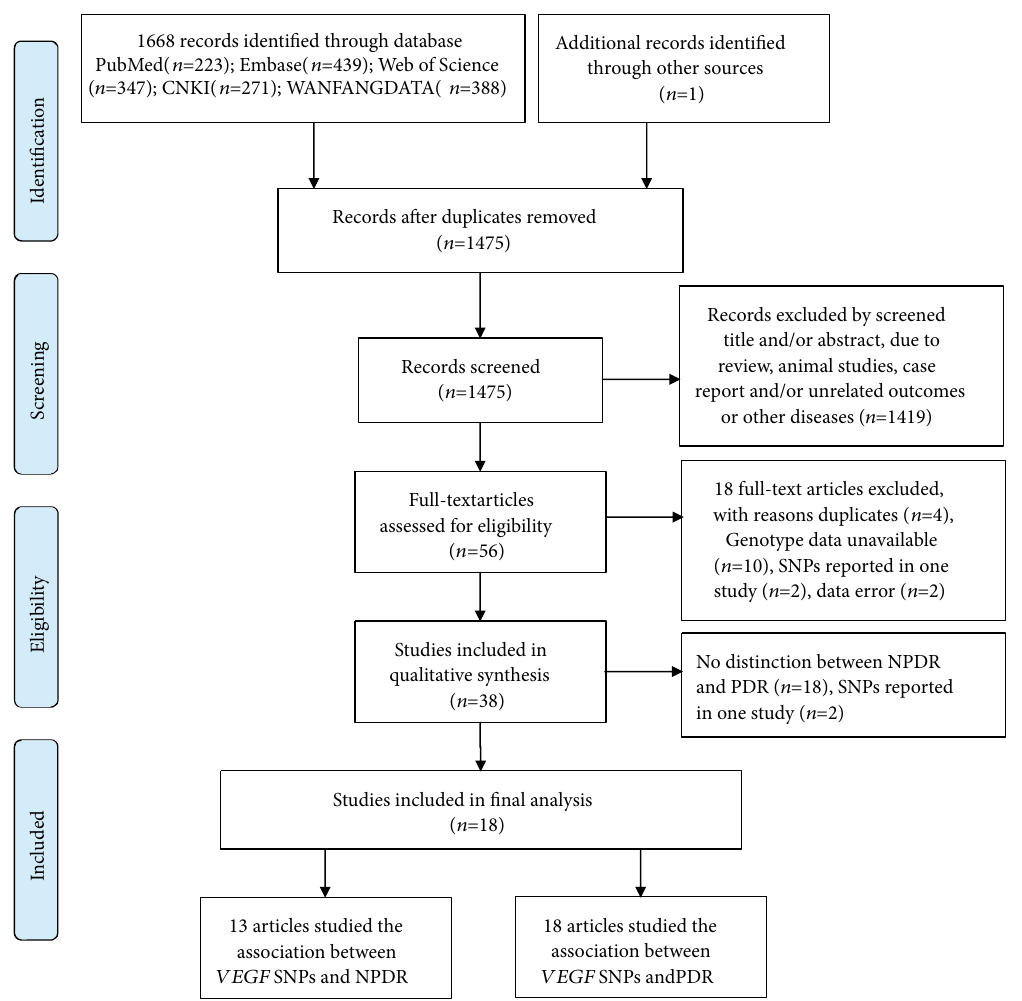
Figure 1: PRISMA fl ow diagram of study selection